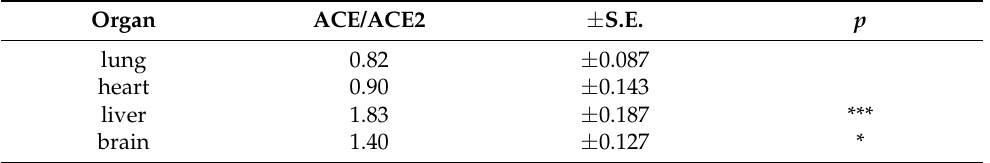
Each ratio is expressed relative to the sham value. Values represent Mean ± SE. * p < 0.05 versus sham, *** p < 0.001 versus